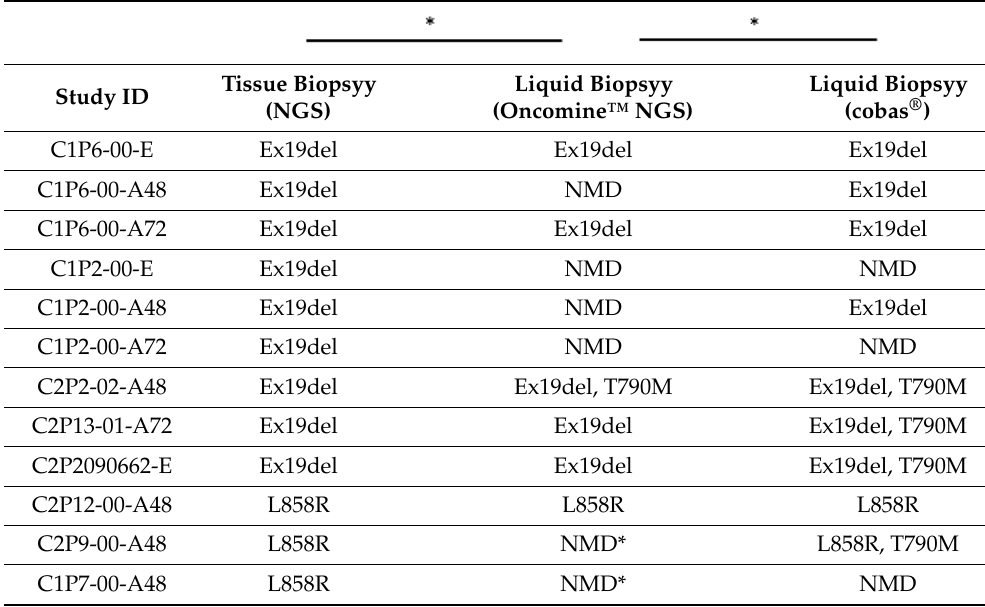
Table 3. Assessment of EGFR mutation detection using NGS and cobas ® EGFR mutation v2 assay.